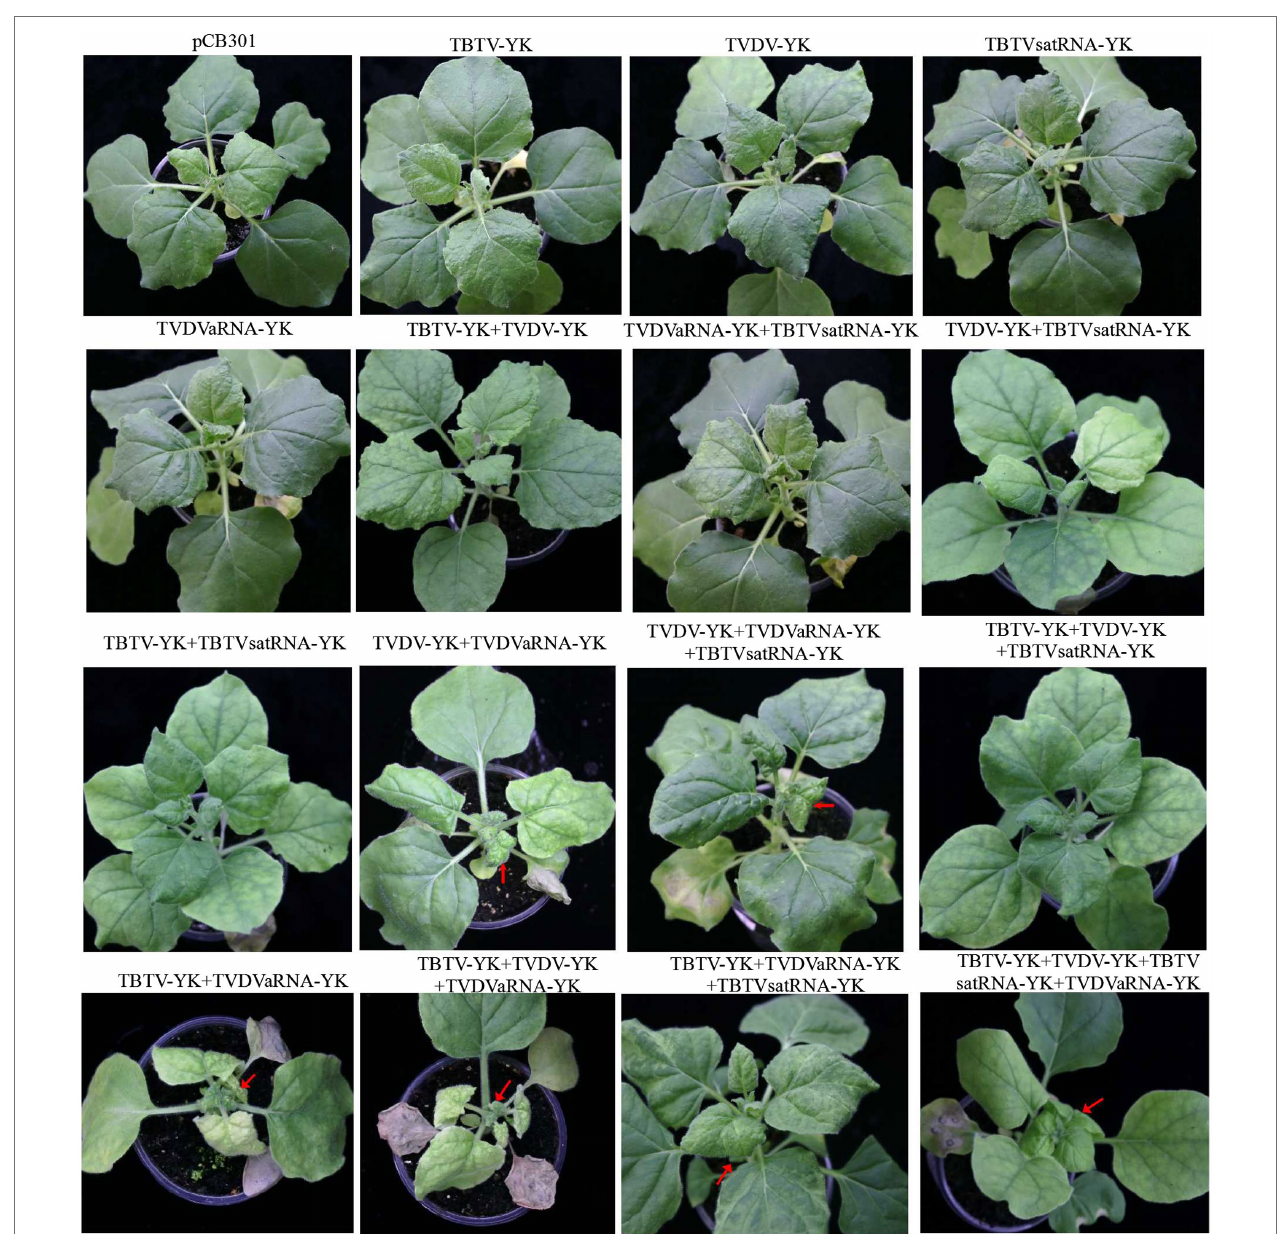
FIGURE 5 | Symptoms on the Nicotiana benthamiana plants inoculated with TBTV-YK, TVDV-YK, TBTVsatRNA-YK, and TVDVaRNA-YK, singly or in various combinations, through agro-infiltration. Arrows indicate curly top-like symptoms. The plants were photographed at 16 days postinoculation. The plant agro-infiltrated with pCB301 (an empty expression vector) was used as a